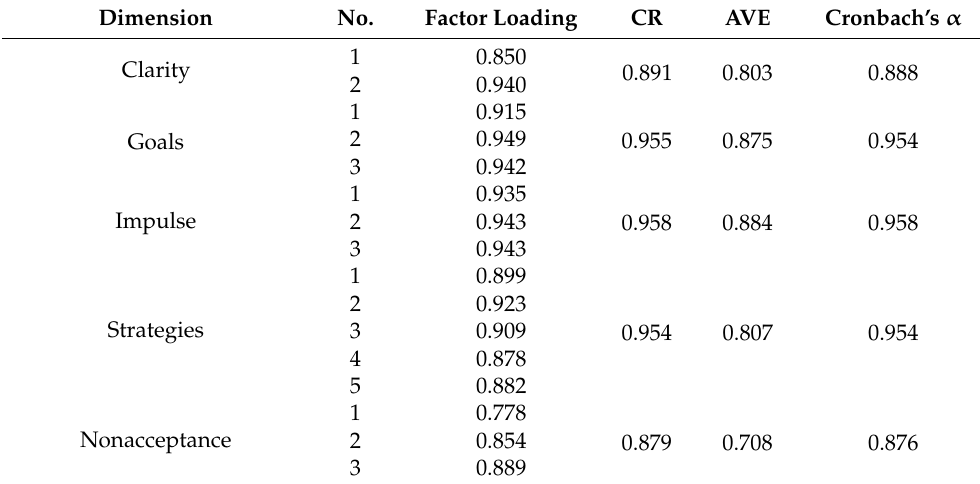
Table 3. Reliability and validity assessment of difficulties in emotion regulation scale. Dimension